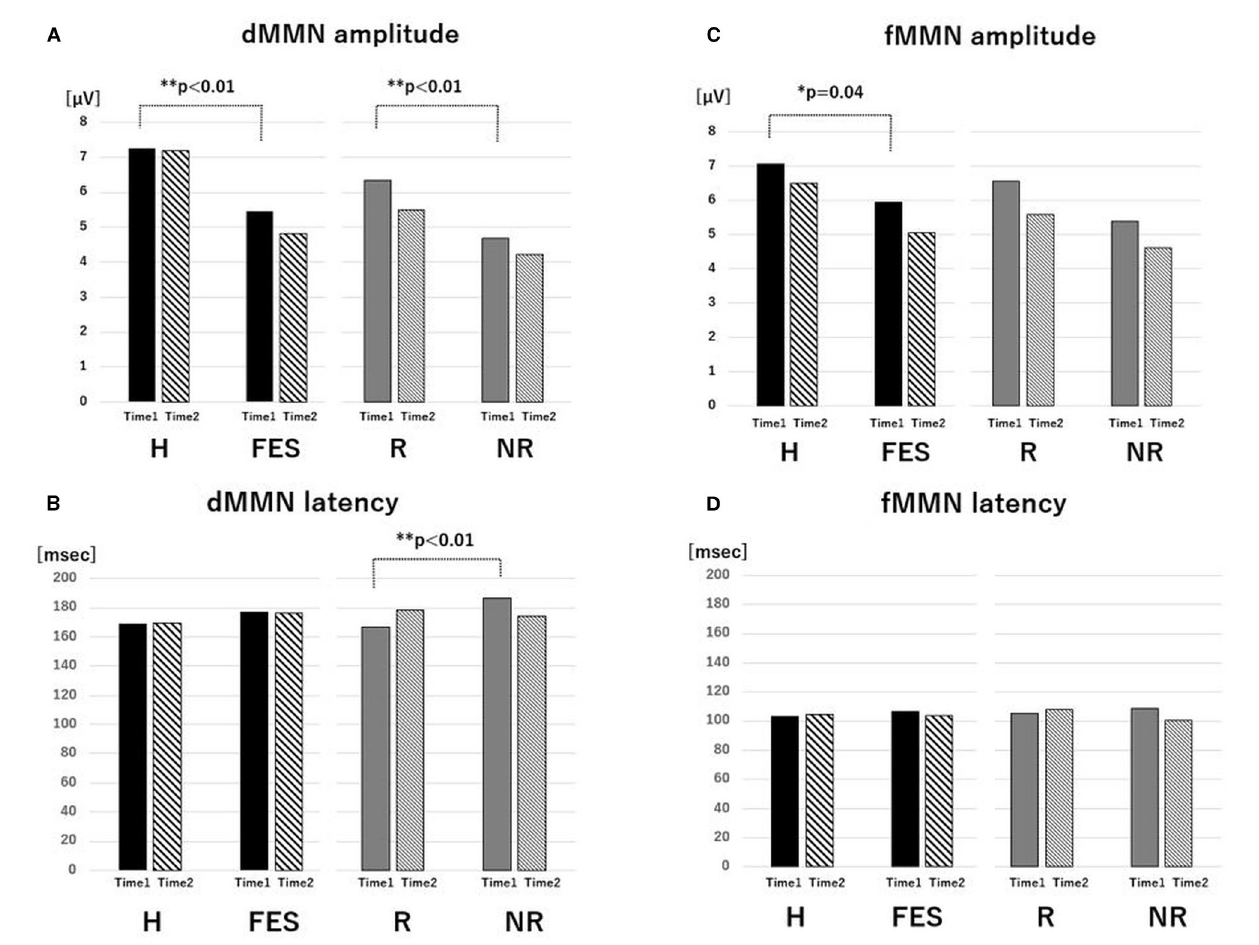
FIGURE 1 | Value of MMN parameters. The average of amplitude (A) and latency (B) of dMMN and the average of amplitude (C) and latency (D) of fMMN for the H, FES, R, and NR groups for Time 1 and Time 2. * P < 0.05, ** P < 0.01, ANCOVA. Abbreviations: dMMN, duration mismatch negativity; fMMN, frequency mismatch negativity; H, healthy control; FES, first episode schizophrenia; R, schizophrenia remitter; NR, schizophrenia non-remitter.